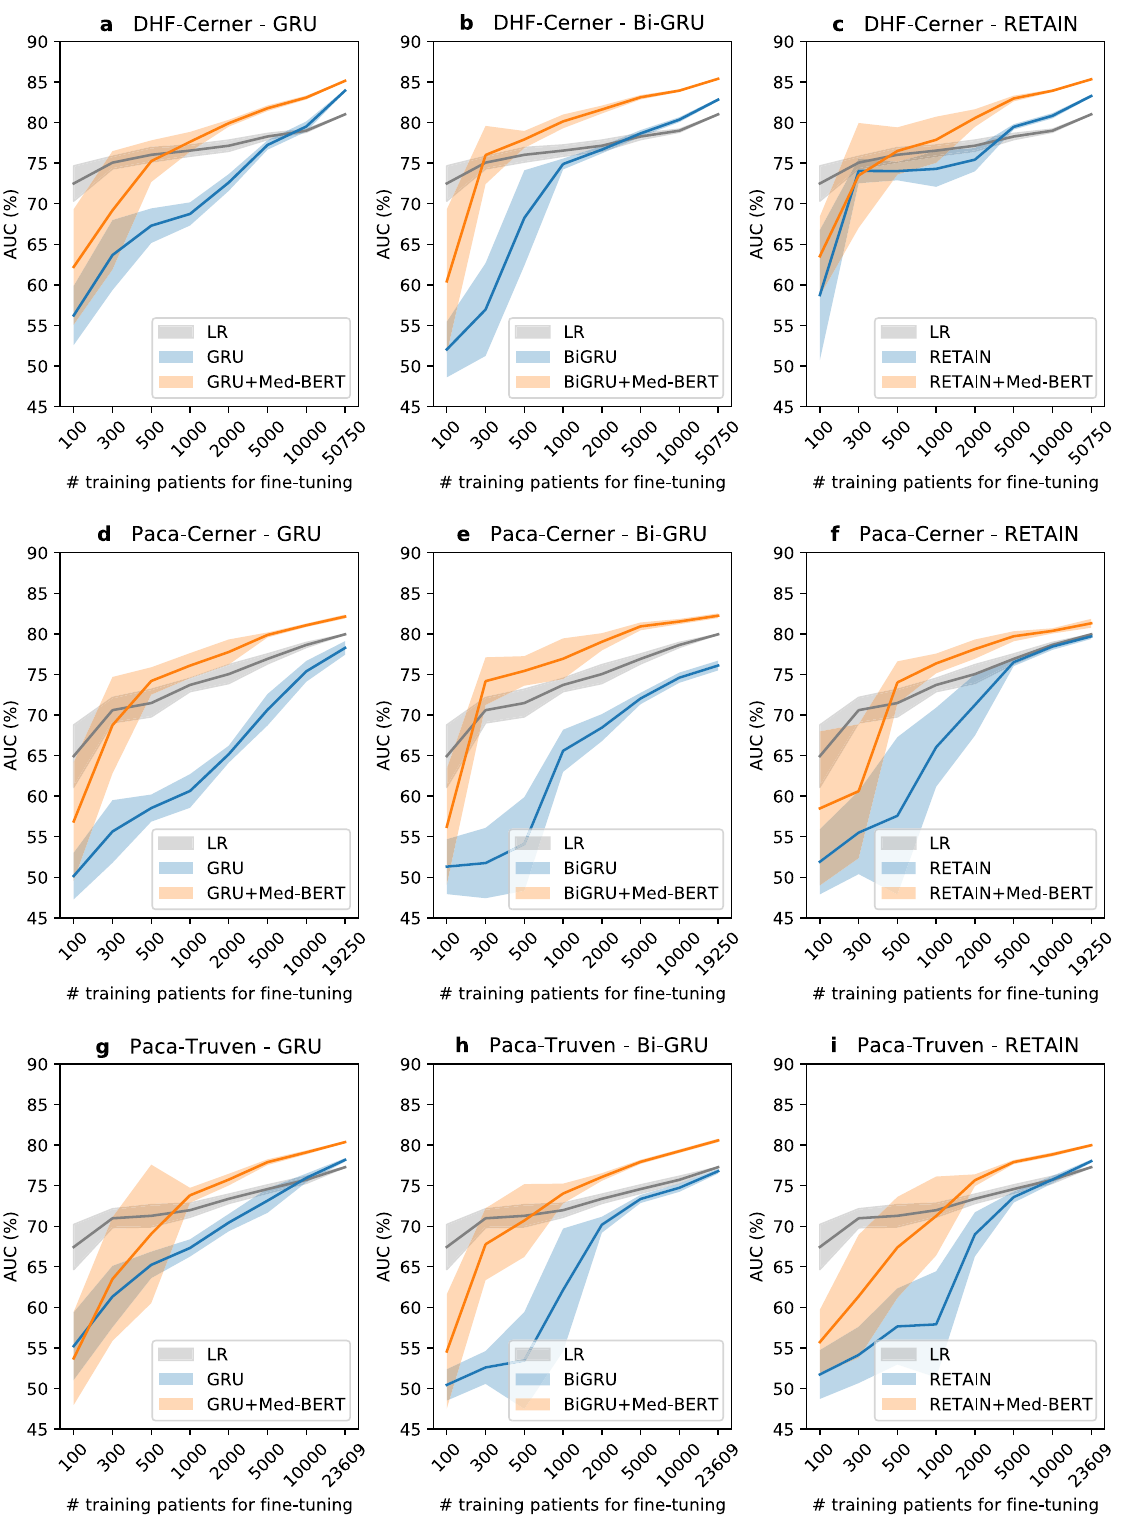
Fig. 4 Comparison of prediction AUC for the test sets by training on different sizes of data on various cohorts between the methods with or without the pretrained Med-BERT layer. Logistic regression (LR) results are included as a baseline. a Cohort: DHF-Cerner, method: GRU; b cohort: DHF-Cerner, method: bidirectional GRU; c cohort: DHF-Cerner, method: RETAIN; d cohort: PaCa-Cerner, method: GRU; e cohort: PaCa- Cerner, method: bidirectional GRU; f cohort: PaCa-Cerner, method: RETAIN; g cohort: PaCa-Truven, method: GRU; h cohort: PaCa-Truven, method: bidirectional GRU; i cohort: PaCa-Truven, method: RETAIN. The shadows indicate the standard